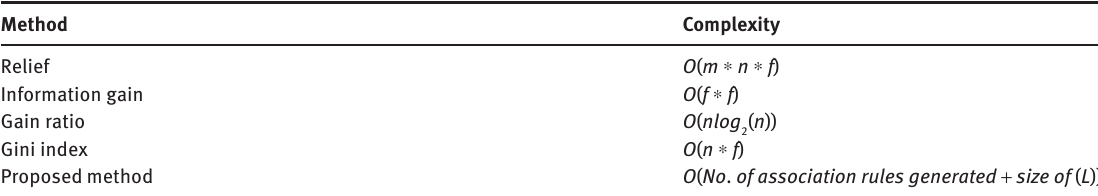
Table 8: Comparision of Time Complexities of Various Methods Used for Feature Selection.